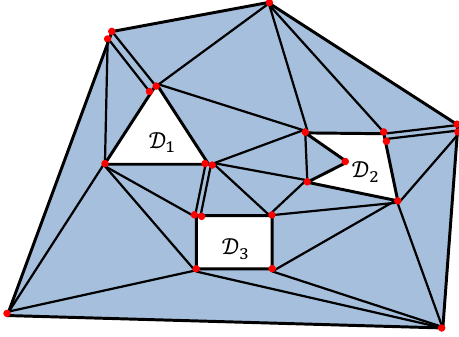
Figure 4. The triangulation T of the polygon Q .